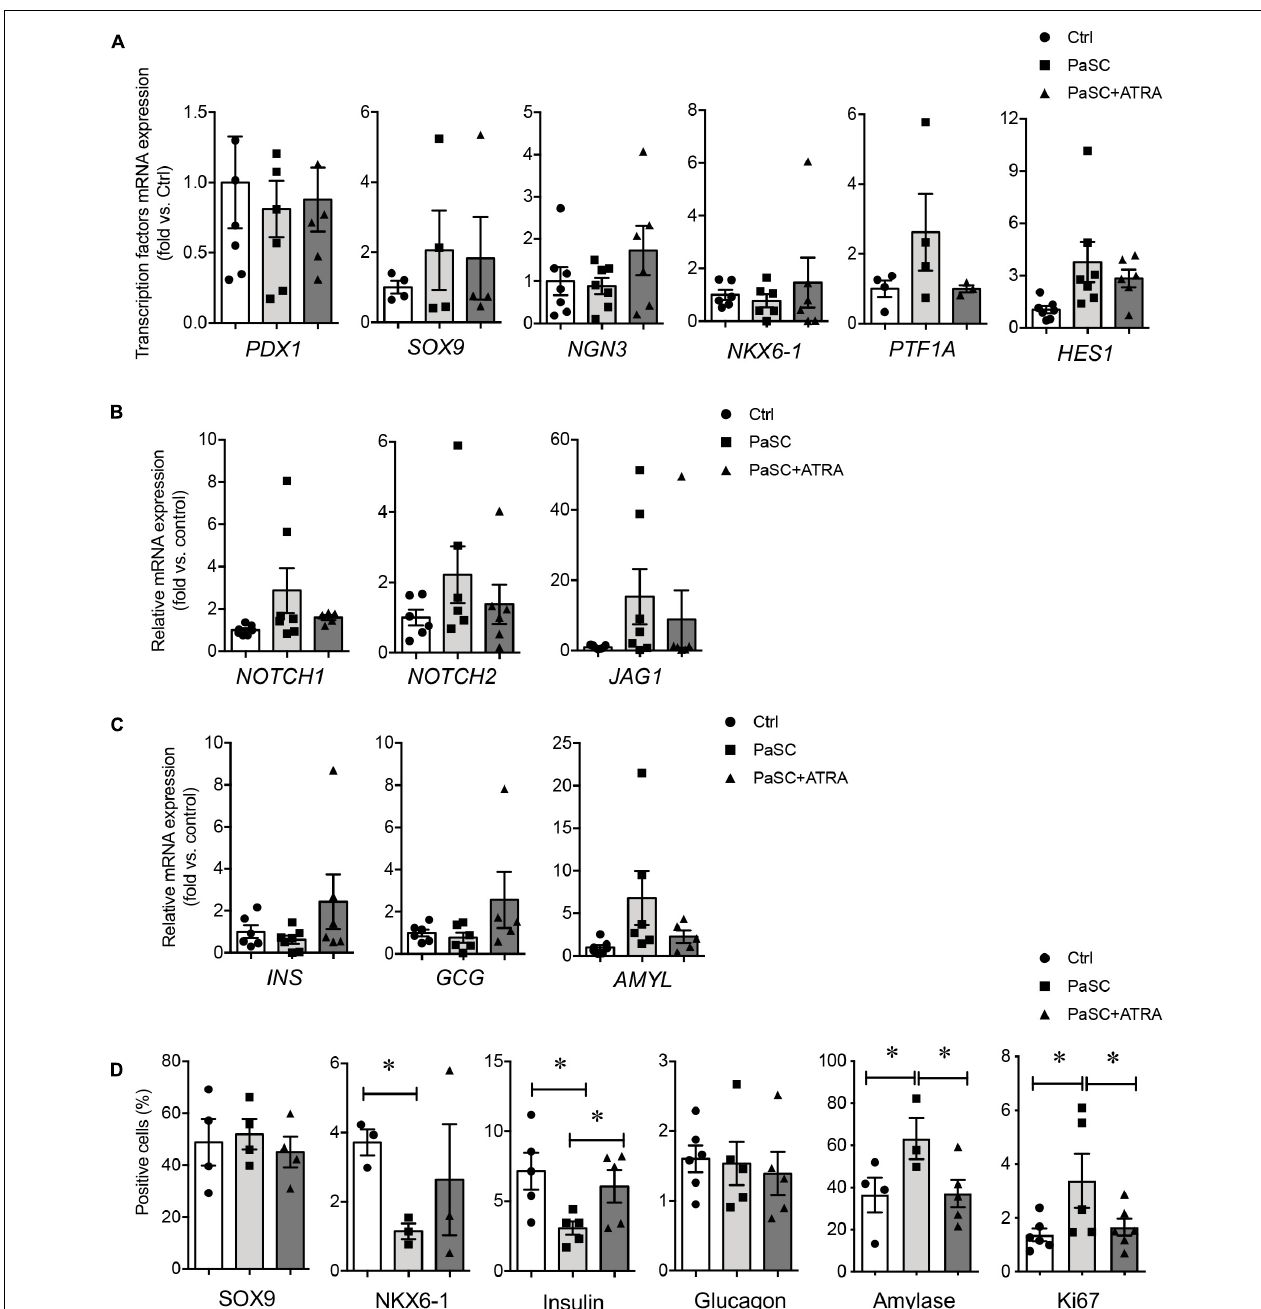
FIGURE 5 | PaSCs promote exocrine cell differentiation in hIECCs during a direct co-culture. qRT-PCR analysis of (A) transcription factor, (B) Notch signals and (C) pancreatic genes expression, and (D) the percentage of SOX9 + , NKX6-1 + , insulin + , glucagon + , amylase + and Ki67 + cells in hIECCs during a direct co-culture with PaSCs for 48 h. Closed circles, control (with no PaSC); closed squares, PaSC; closed triangle, PaSC + ATRA. Data are expressed as mean ± SEM ( n = 3–7 experiments/treatment group). ∗ p < 0.05; analyzed using one-way ANOVA with Tukey’s post hoc